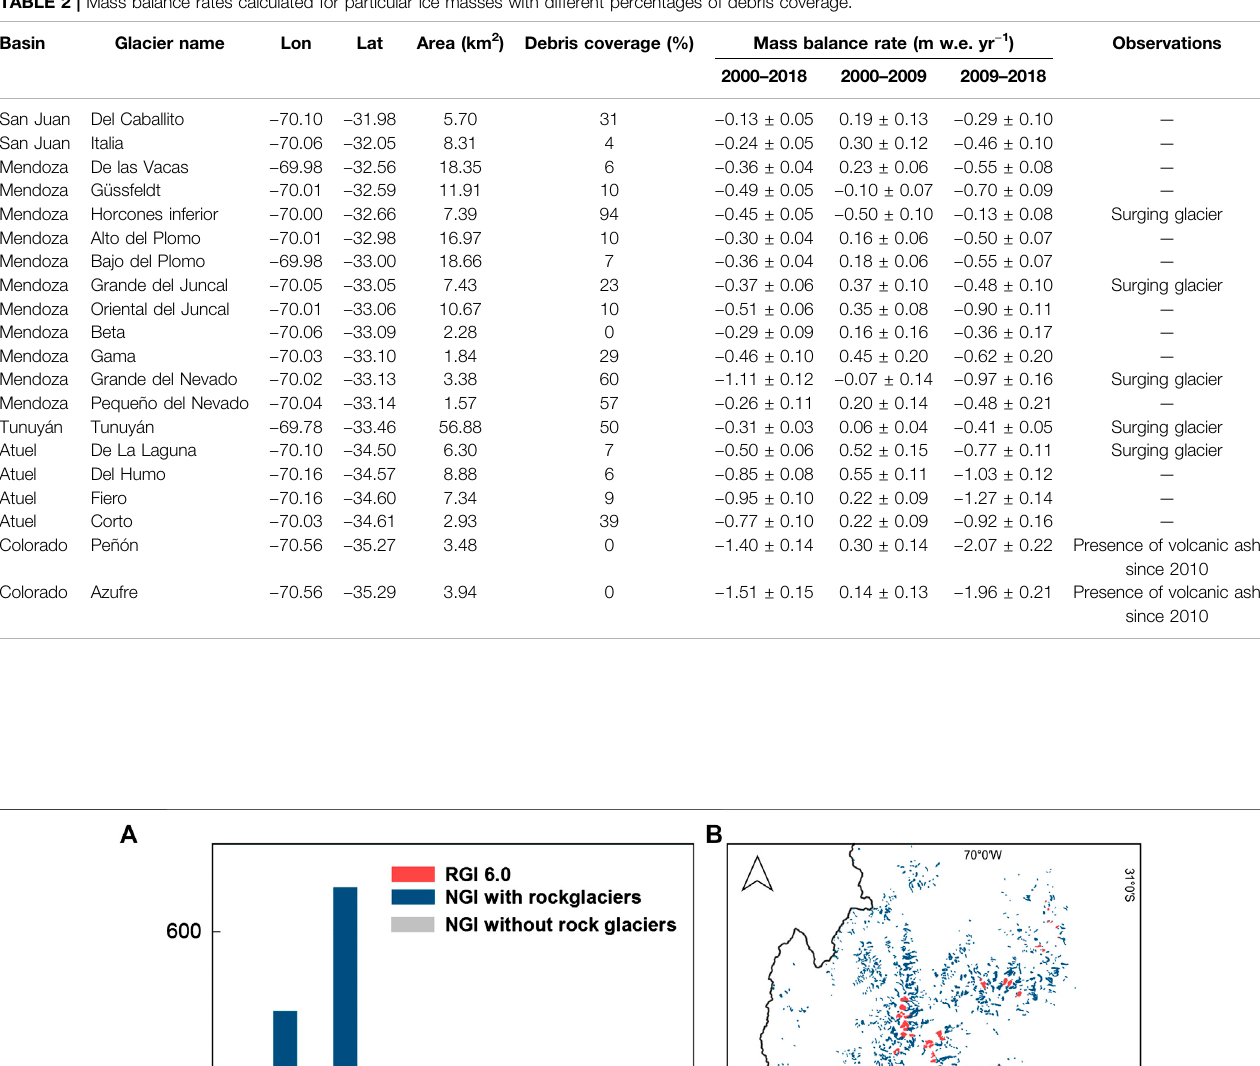
TABLE 2 | Mass balance rates calculated for particular ice masses with different percentages of debris coverage.